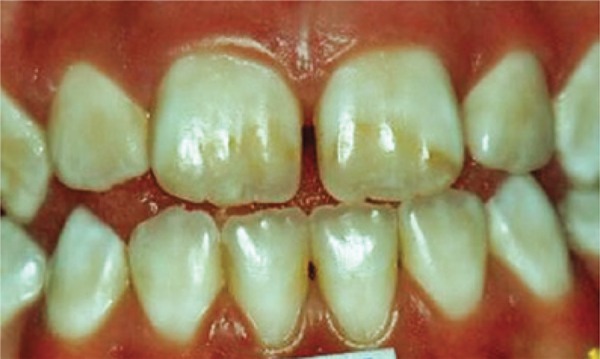
Dentes com fluorose moderada